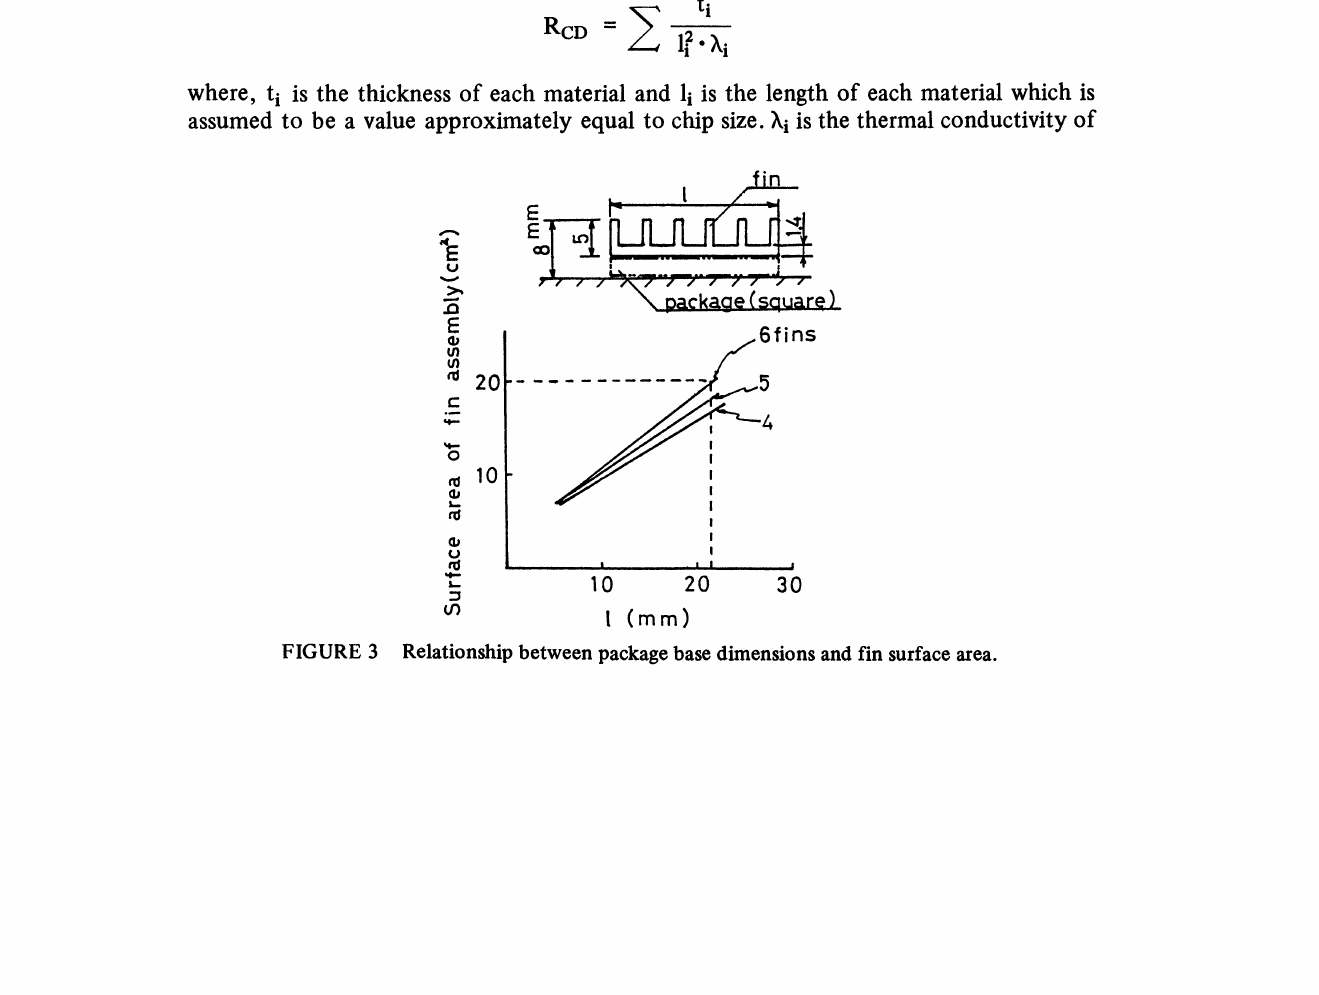
space for air flow L j...._fin, assembl_ FIGURE 2 Limitation of package height based on stacked plug-in board spacing.